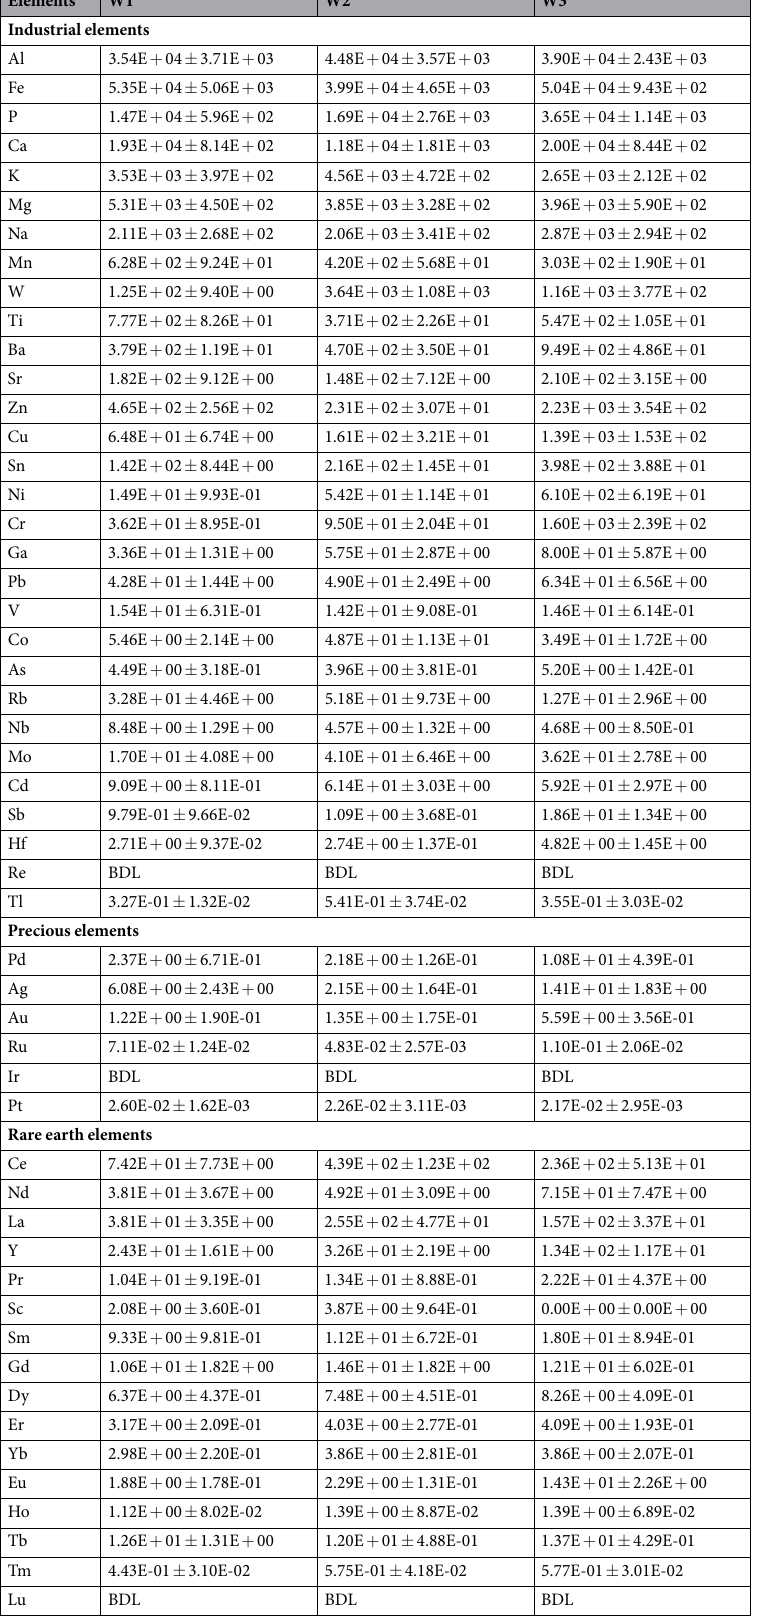
Table 2. Average annual concentrations (mg kg − 1 DS) of detected elements in the sewage sludge (n = 4). BDL = below detection